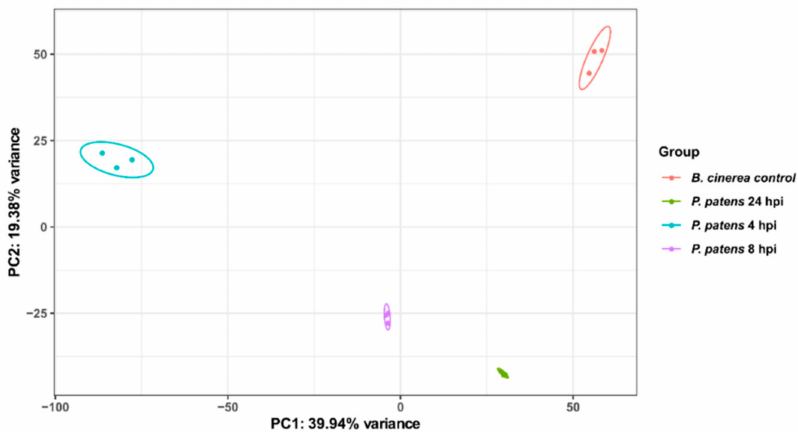
Figure 1. Analysis of B. cinerea RNA-Seq data during P. patens infection by principal component analysis (PCA). Variation among the three biological replicates per sample ( P. patens 4 hpi, P. patens 8 hpi, P. patens 24 hpi and B. cinerea control), is shown. Colored dots denote each biological